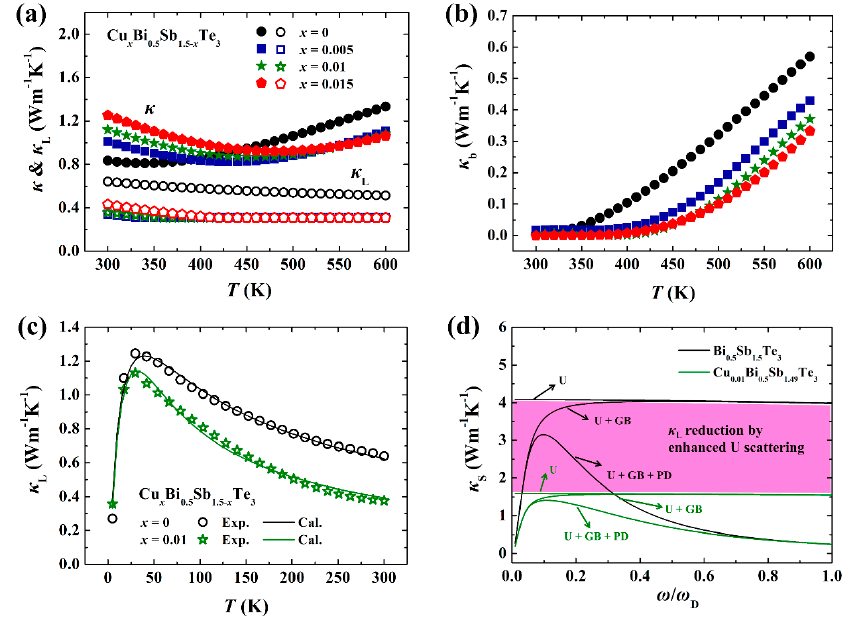
Figure 5. Temperature dependences of ( a ) total thermal conductivity κ (and lattice thermal conductivity κ L ) and ( b ) bipolar thermal conductivity κ b for Cu x Bi 0.5 Sb 1.5- x Te 3 samples. The data for x = 0 and x = 0.005 are taken from [8]; ( c ) Low-temperature κ L for Bi 0.5 Sb 1.5 Te 3 and Cu 0.01 Bi 0.5 Sb 1.49 Te 3 . The solid lines are the fitting results by Debye model; ( d ) Contribution of phonon–phonon Umklapp scattering (U), point defects scattering (PD), and grain boundary scattering (GB) to the total κ L for Bi 0.5 Sb 1.5 Te 3 and Cu 0.01 Bi 0.5 Sb 1.49 Te 3 at 300 K. The color-filled area represents the reduction of κ L by enhanced U scattering in Cu 0.01 Bi 0.5 Sb 1.49 Te 3 .